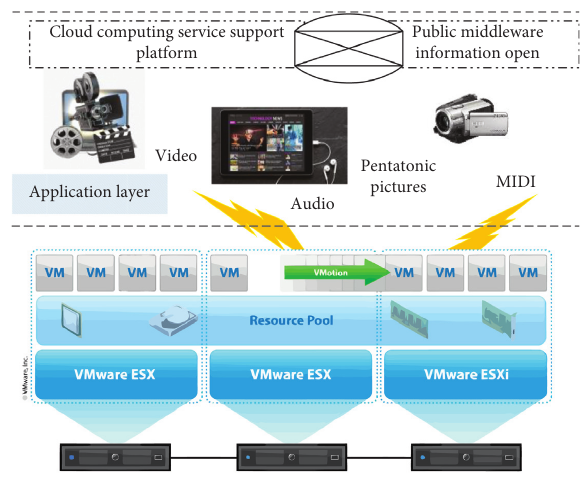
Figure 3: Learner model